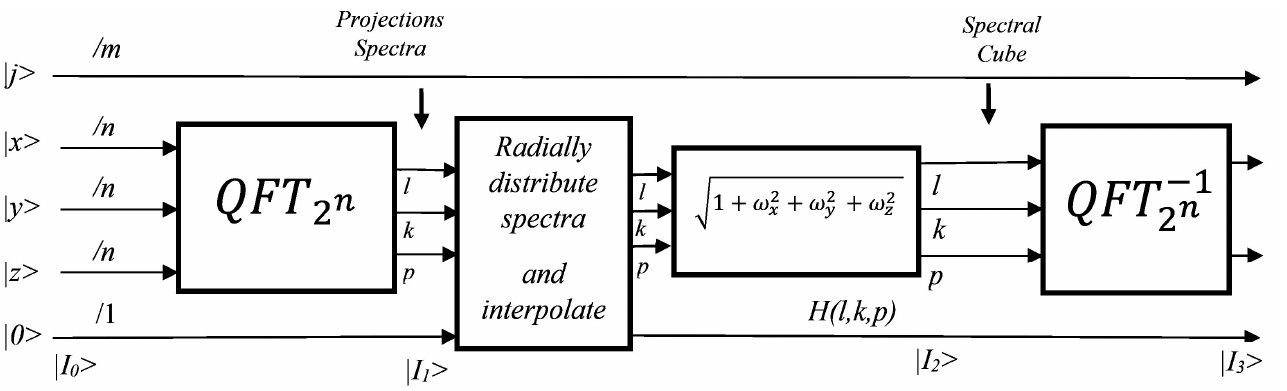
Figure 12. The Radon and the inverse Radon transform using 2D QFT and 3D inverse QFT for image cube